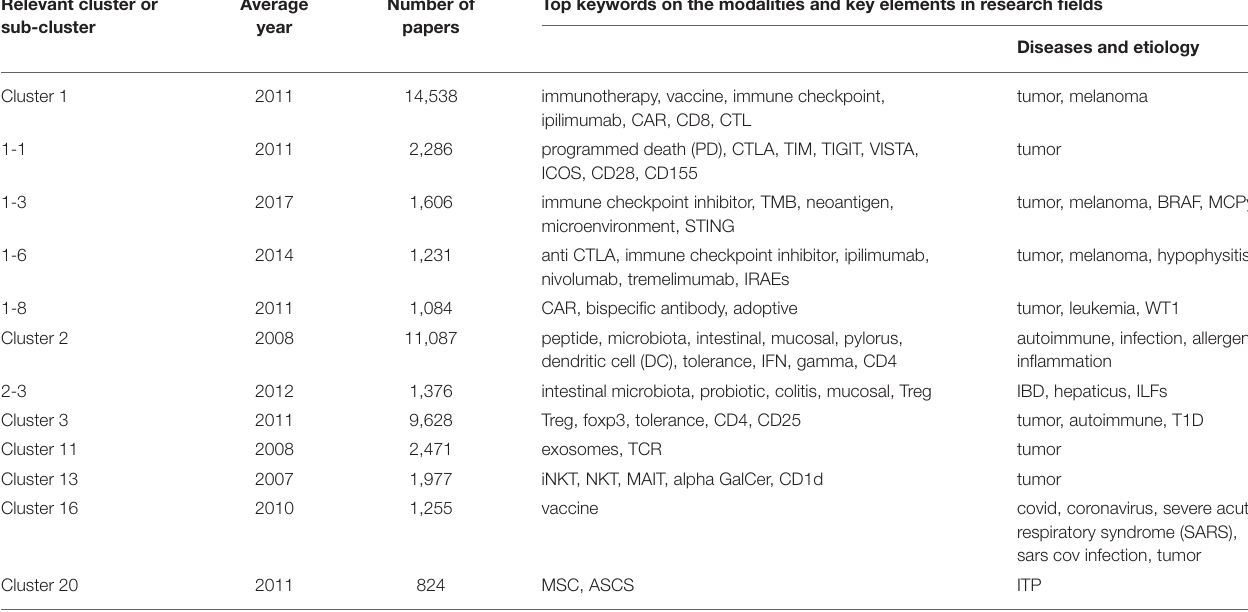
Top keywords on the modalities and key elements in research fields